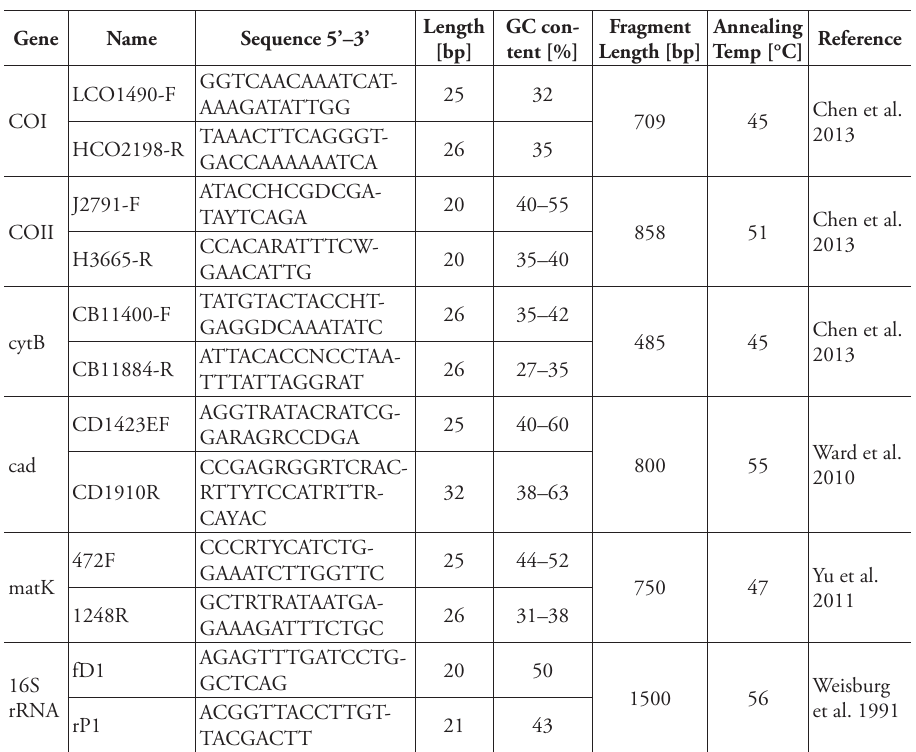
Table 1. Primers used in this